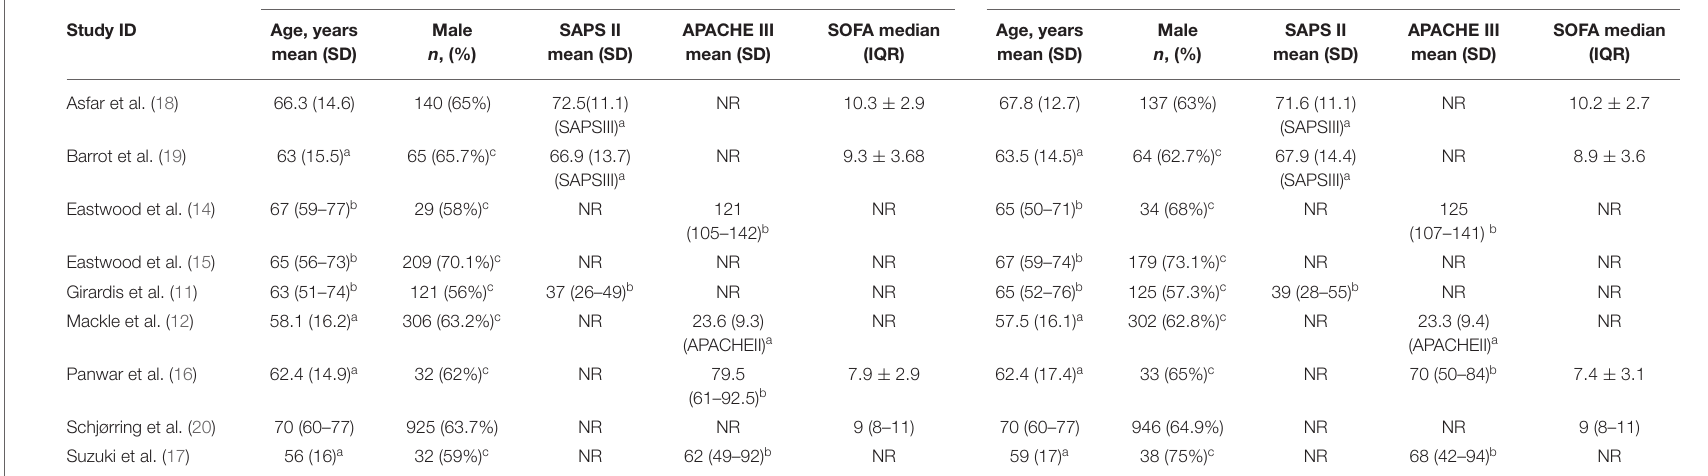
TABLE 2 | Baseline characteristics of